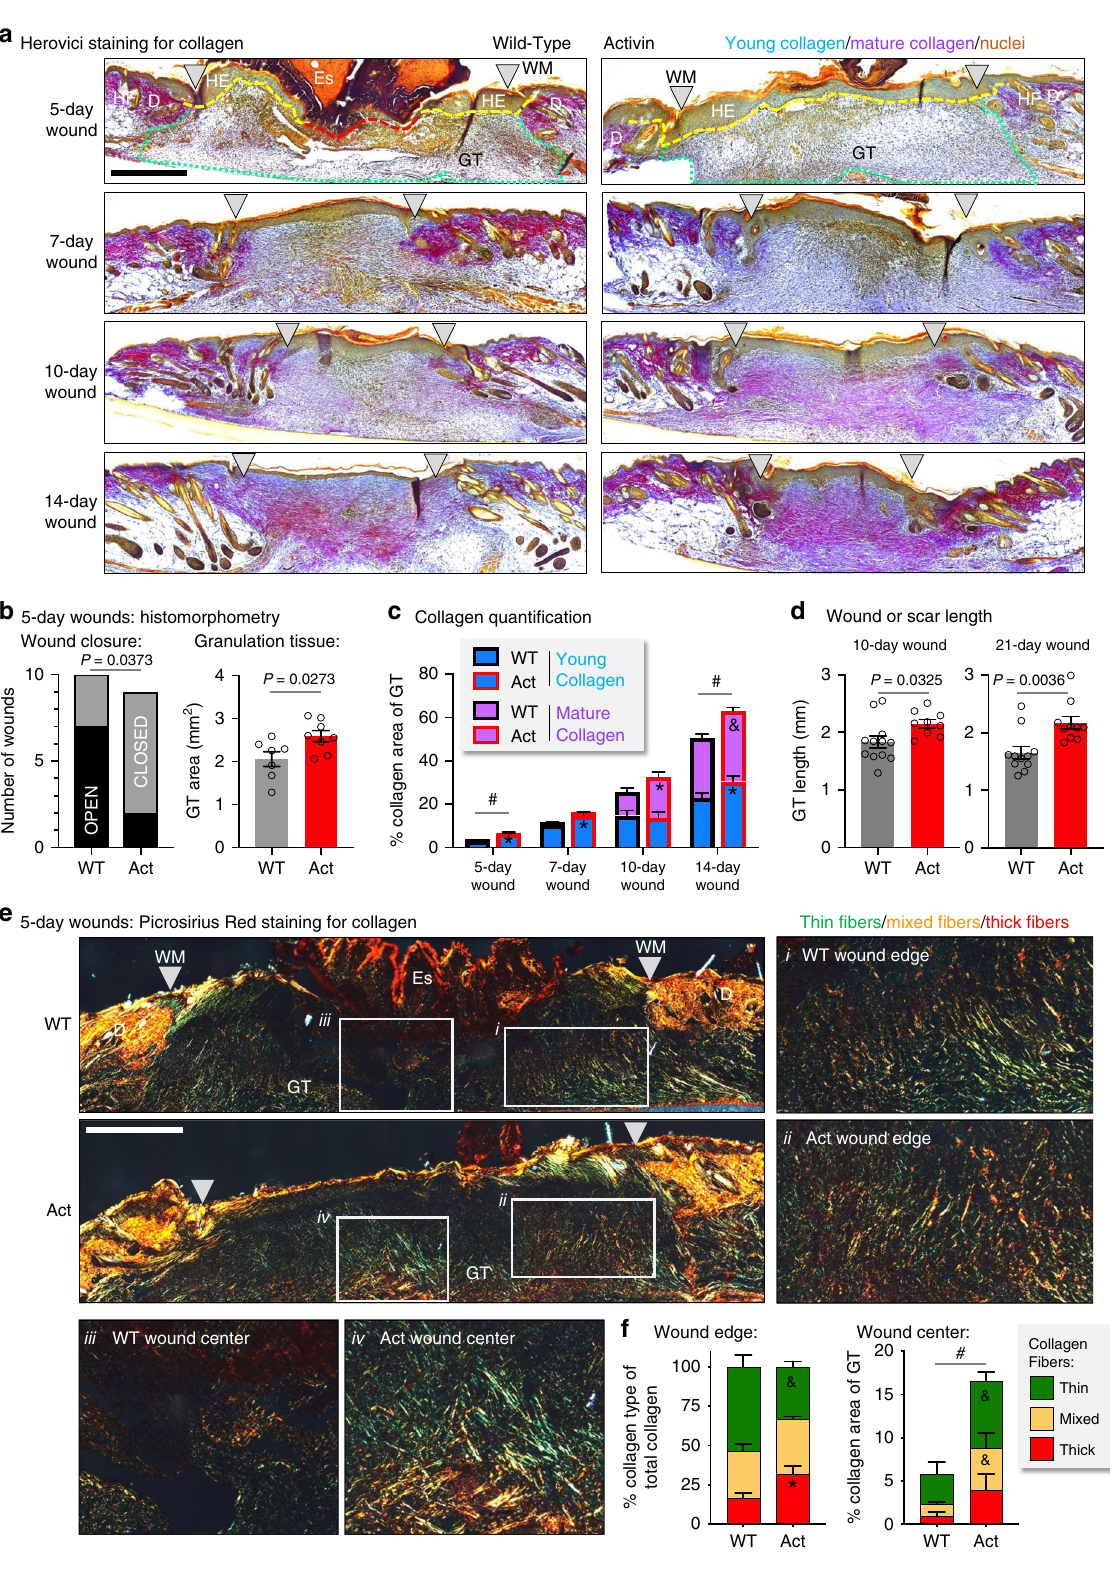
Fig. 2e, f), re fl ecting the previously described activin autoregula- tion 28 , while other activin genes and also activin receptor genes were not regulated (Supplementary Fig. 2c, right).